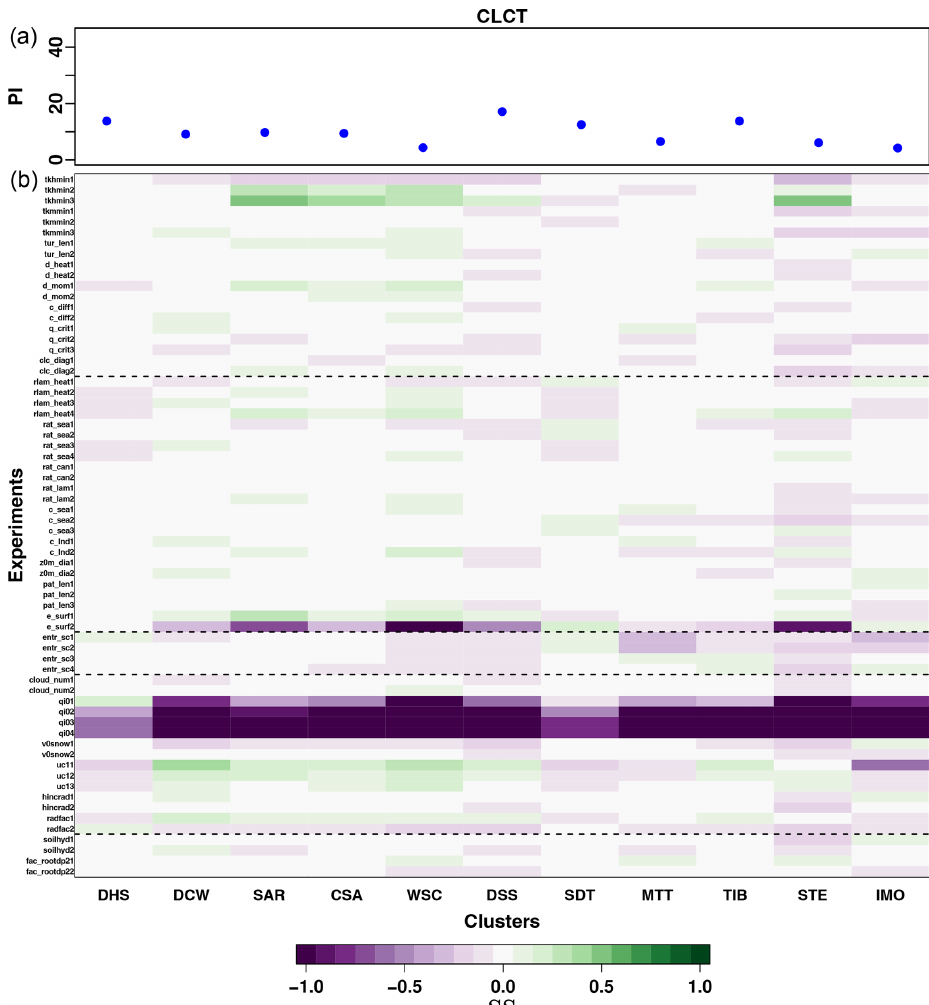
Figure 7. (a) PI calculated for total cloud cover (CLCT) for the reference experiment with default parameter values, over each of the 11 Central Asia subregions. (b) Changes in the SS of each performed experiment, calculated with respect to the default simulation, for CLCT: green (violet) values indicate a better (worse) agreement with observations with respect to the default simulation. The experiments for each parameter are enumerated in an increasing order, according to its tested values, from the lowest to the highest. The different simulations are additionally grouped depending on the main physical scheme the tested parameter is characteristic of, in the same way as they are in Table